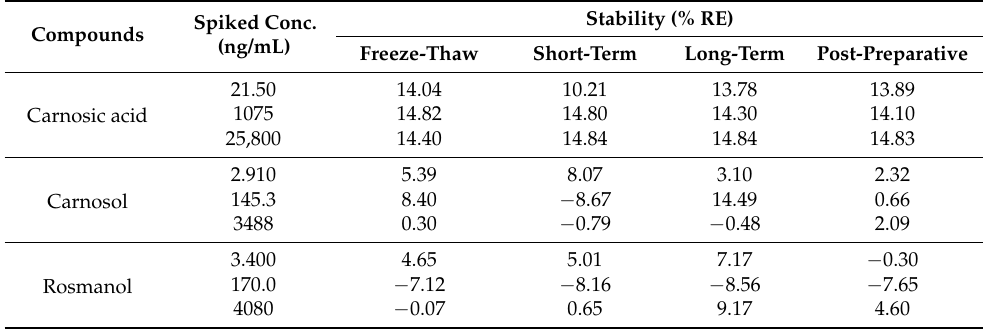
Table 4. The stability of the three diterpenes in rat plasma under different storage conditions ( n = 6). Stability (% RE) Spiked Conc. Compounds (ng/mL) Freeze-Thaw Short-Term Long-Term Post-Preparative Carnosic